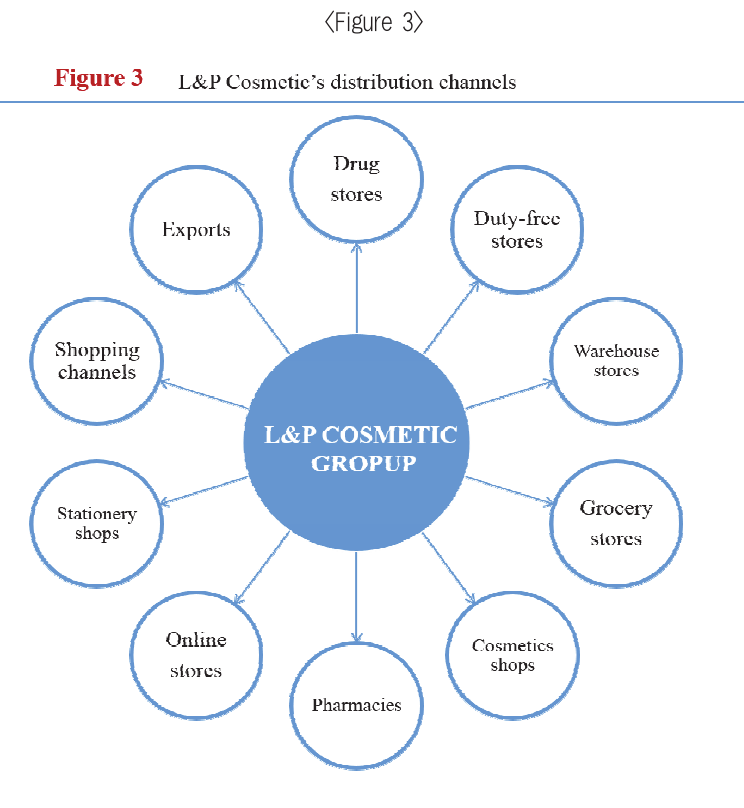
Figure 3. Mr. Kwon’s efforts to construct a secure distribution network, along with his commitment to the quality of the products, were the two pillars of L&P Cosmetic’s